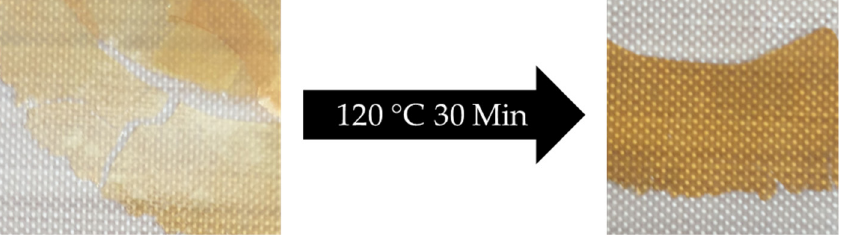
Figure 13. Reshaping of cracked P(BA 60 - co -FMA 40 ) 10 crosslinked with BMI with a motif ratio of 1:1 at room temperature. Broken polymeric film on the left side and cured polymeric film on the right side.